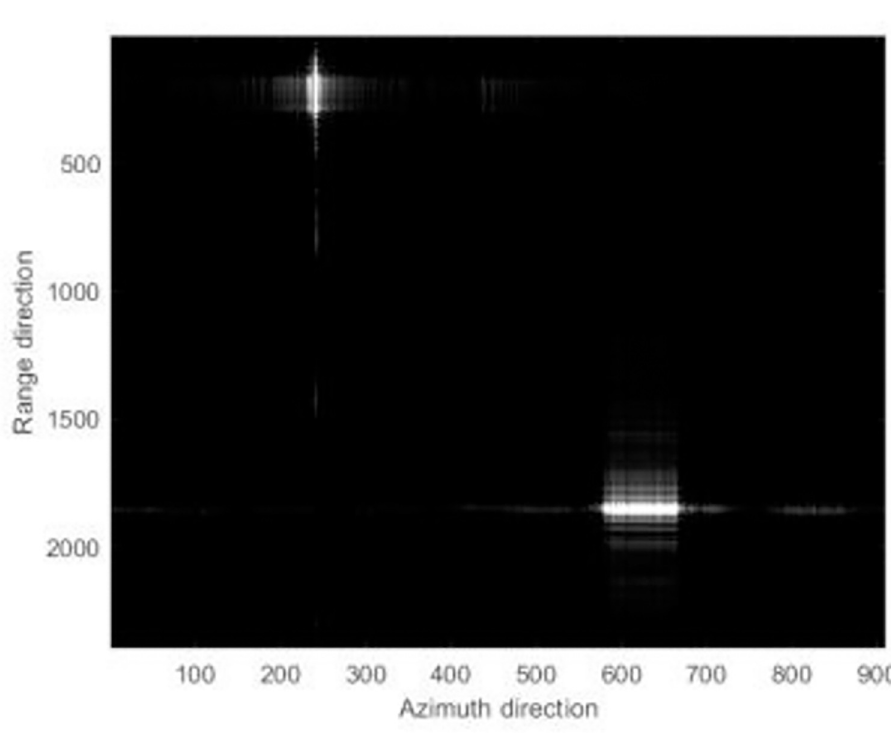
Fig 6. The simulation focused